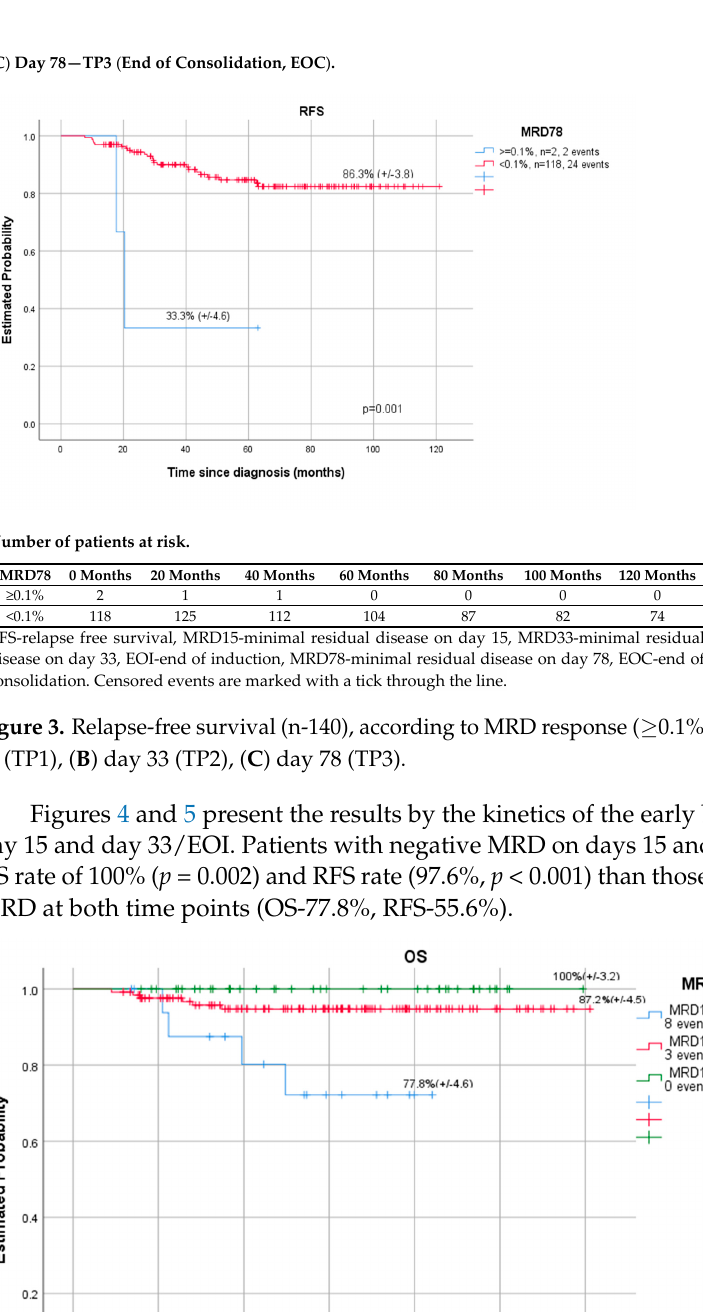
( C ) Day 78—TP3 ( End of Consolidation, EOC ) .